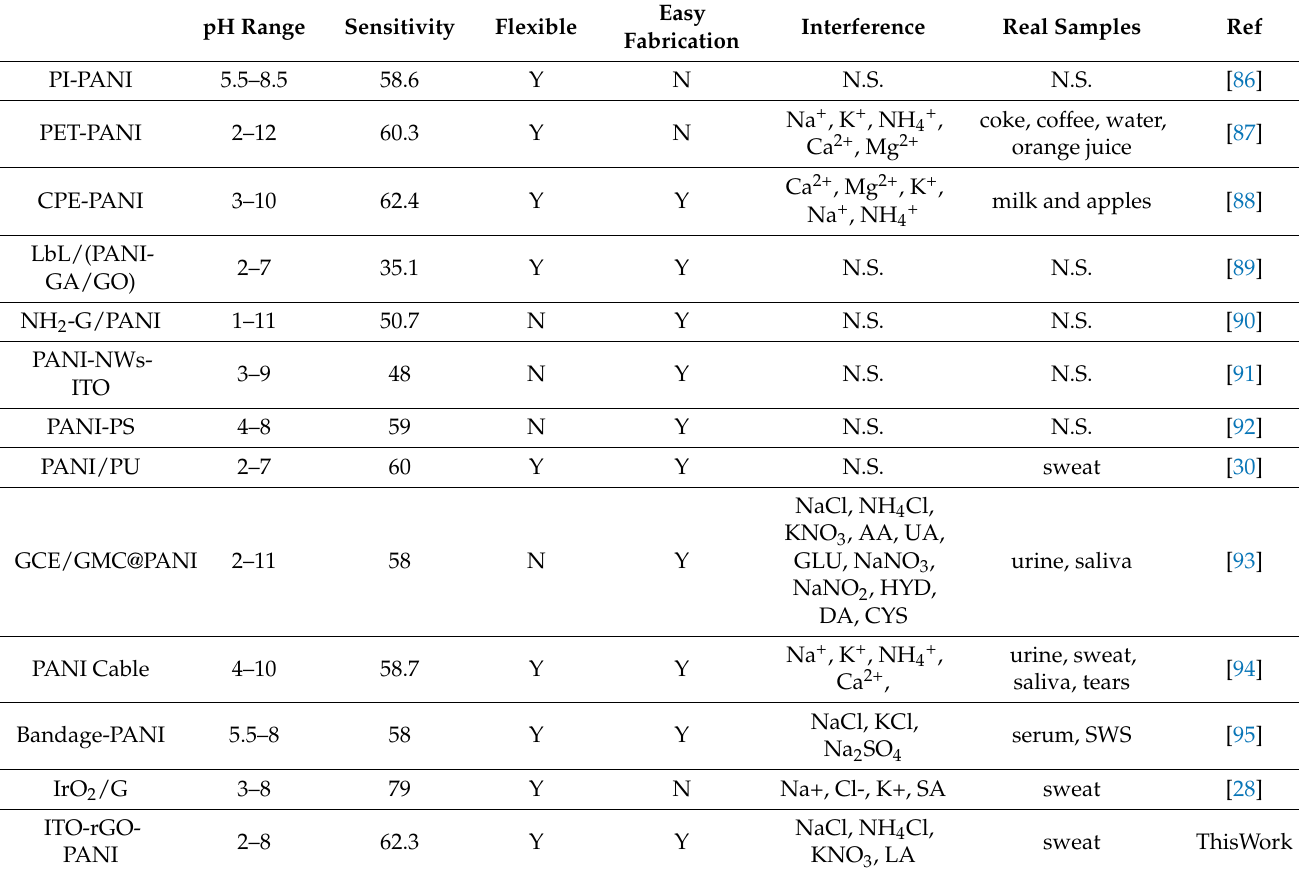
Table 1. Comparison between pH electrochemical